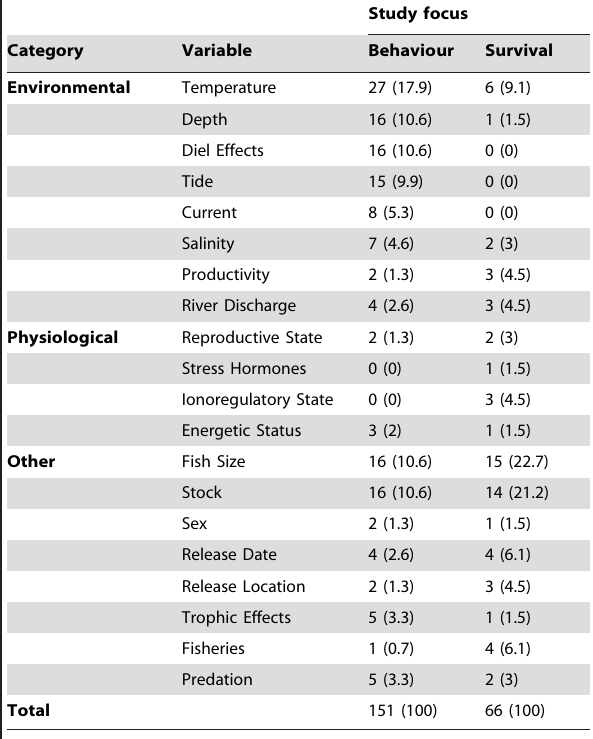
Table 5. Number and frequency (% within parentheses) of a variable being found significant out of the total number of significant findings for behaviour (n=151) or survival